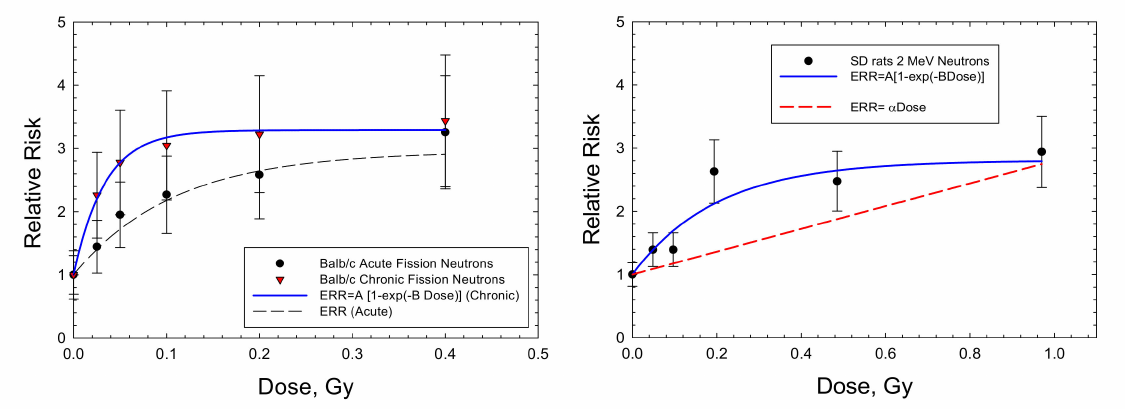
Figure 4. Dose responses for relative risk of mammary adenocarcinomas in Balb/c mice [6] and Sprague-Dawley rats [19] exposed to fission neutrons or neutron sources with average energy 2 MeV. The saturable ERR model described in the text is compared to the experimental data.